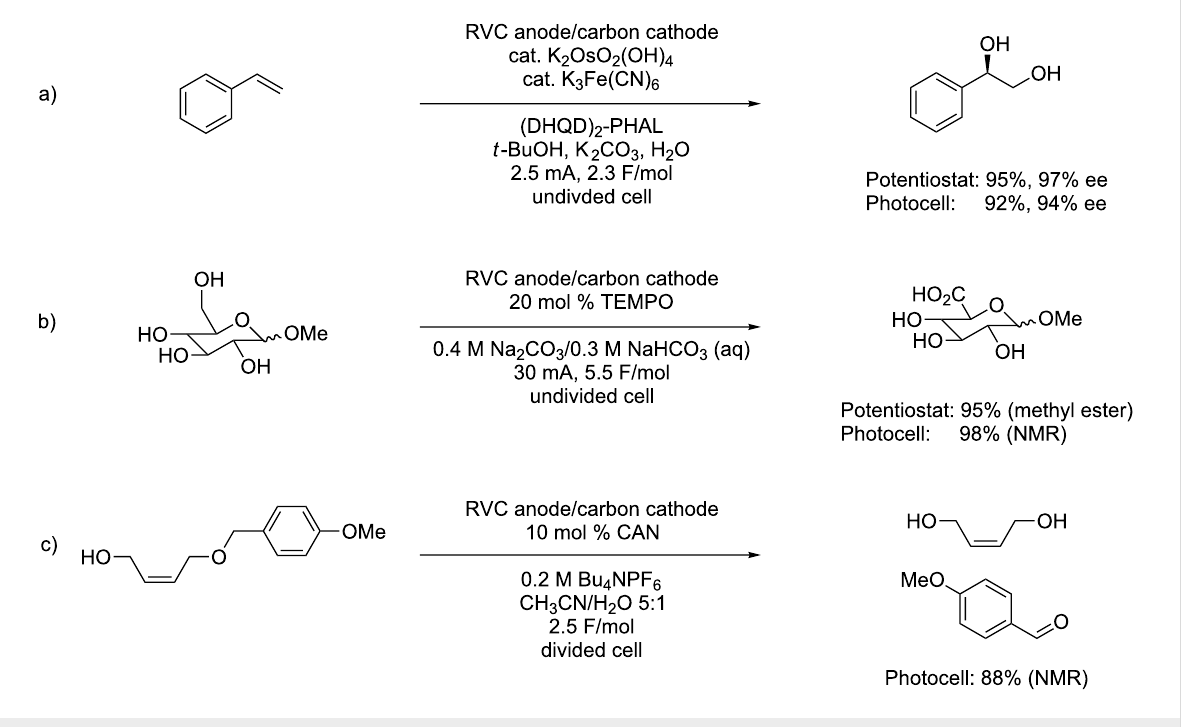
which would select the oxidation based exclusively on poten- tial. Again, the yield from the light-driven process is compa- rable to the literature value for the